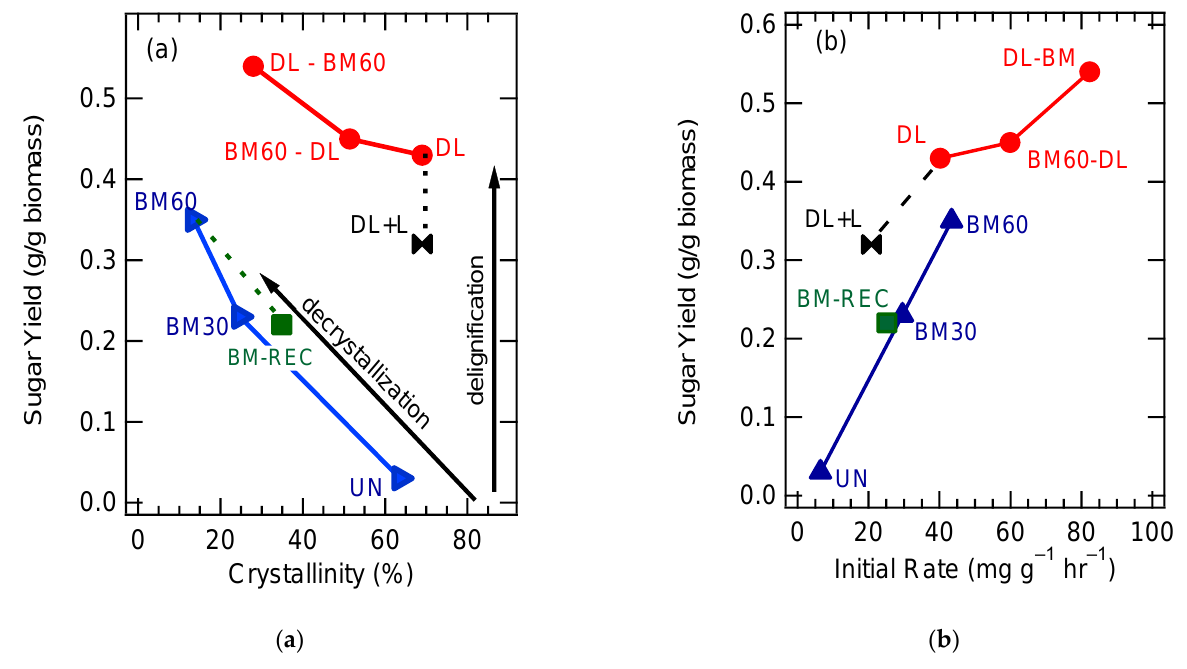
Figure 3. Interdependence of sugar yields, sugar formation rates, and crystallinity for the samples listed in Table 1; ( a ) sugar yields as a function of crystallinity (determined from XRD, see Figure S2 for diffractograms), ( b ) sugar yields as a function of initial formation rates.